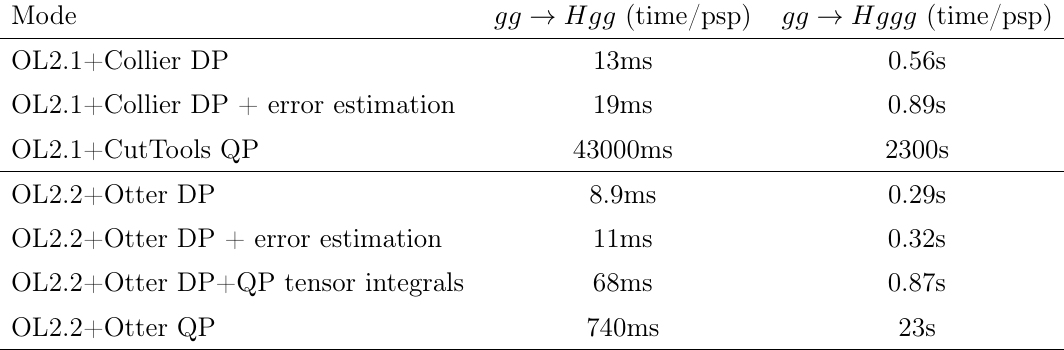
Table 1 . Runtimes for loop-squared amplitudes for gg ! Hgg and gg ! Hggg in OpenLoops